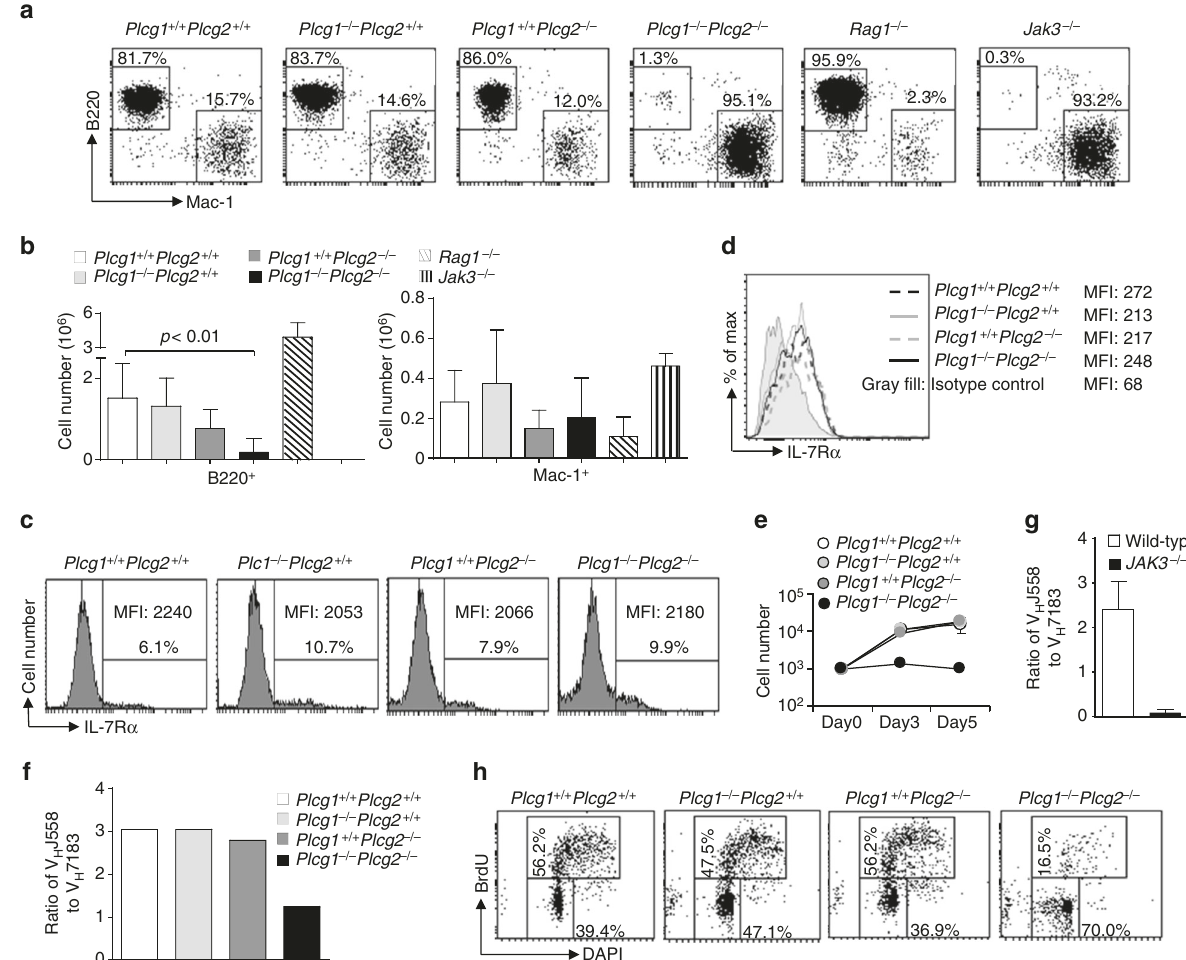
Fig. 2 PLC γ 1/PLC γ 2 double de fi ciency impairs IL-7-mediated B cell progenitor functions. BM from Plcg1 + / + Plcg2 + / + , Plcg1 − / − Plcg2 + / + , Plcg1 + / + Plcg2 − / − , or Plcg1 − / − Plcg2 − / − mice were transplanted into lethally irradiated congenic wild-type CD45.1 + mice. Six to eight weeks after transplantation, Lin − BM cells from the recipients, Rag1 − / − or Jak3 − / − mice were cultured on OP9 cells plus IL-7. a , b IL-7-dependent B cell production. The cells were stained with anti- CD45.2, anti-B220, and anti-Mac-1 after 9 days of co-culture. Numbers indicate percentages of B220 + and Mac-1 + cells in the gated CD45.2 + population ( a ). Bar graphs show the numbers of CD45.2 + B220 + and CD45.2 + Mac-1 + cells ( b ). c , d IL-7R expression. BM cells from the recipients were stained with anti-IL-7R α . Numbers indicate percentages of IL-7R α + cells in the gated CD45.2 + Lin − population ( c ). After 9 days of co-culture plus Flt-3L, the cells from the recipients were stained with anti-CD45.2, anti-B220, and anti-IL-7R α . Levels of IL-7R α expression in the gated CD45.2 + B220 + population are shown ( d ). e Expansion in response to IL-7. Fractions B and C of B cell progenitors (YFP + CD45.2 + B220 + CD43 + CD24 + ) were sorted from the recipients and cultured with OP9 plus IL-7. On the indicated days after co-culture, the numbers of live cells were determined by trypan blue exclusion. f , g IL-7-mediated rearrangement of the distal V H J558 family gene segments of IgH chain genes. YFP + CD45.2 + B220 + CD43 + or B220 + IgM − CD43 + pro-B cells were sorted from the recipients ( f ) or from wild-type or Jak3 − / − mice ( g ), respectively. The frequency of V H J558 and V H 7183 family usage in these progenitors was determined by high-throughput sequencing of the rearranged IgH genes. Bar graphs show the ratios of percentages of rearranged V H J558 genes to those of rearranged V H 7183 genes in the pro-B cells. h IL-7-mediated B cell progenitor proliferation. YFP + CD45.2 + B220 + CD43 + CD24 + B cell progenitors (fractions B and C) were sorted from the recipients, and co-cultured with OP9 cells plus IL-7 for 3 days. BrdU incorporation and DAPI staining were used to determine proliferation. Numbers indicate percentages of BrdU + cells in the gated live cells. Error bars show ± SEM. Data shown are obtained from or representative of 6 ( a , b ), 4 ( c , h ), or 2 ( d – f ) independent experiments or from three wild-type and 2 Jak3 − / − mice ( g